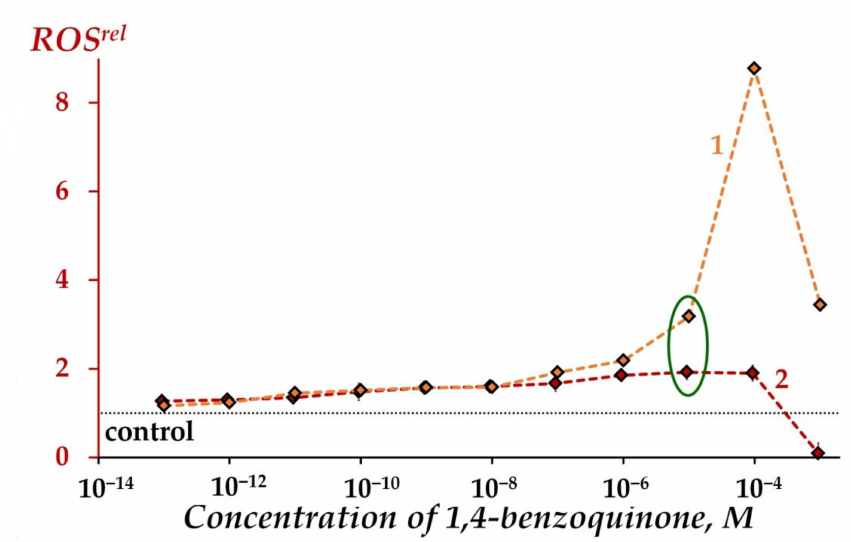
Figure 5. Relative ROS content, ROS rel , in distilled water (1), enzymatic system (2) at different concentrations of 1,4-benzoquinone, 5 min exposure. Concentrations of ROS were 4.5 · 10 − 7 M and 1.9 · 10 − 5 M in distilled water and enzymatic system, respectively. “Control” corresponds to the absence of 1,4-benzoquinone in the experimental